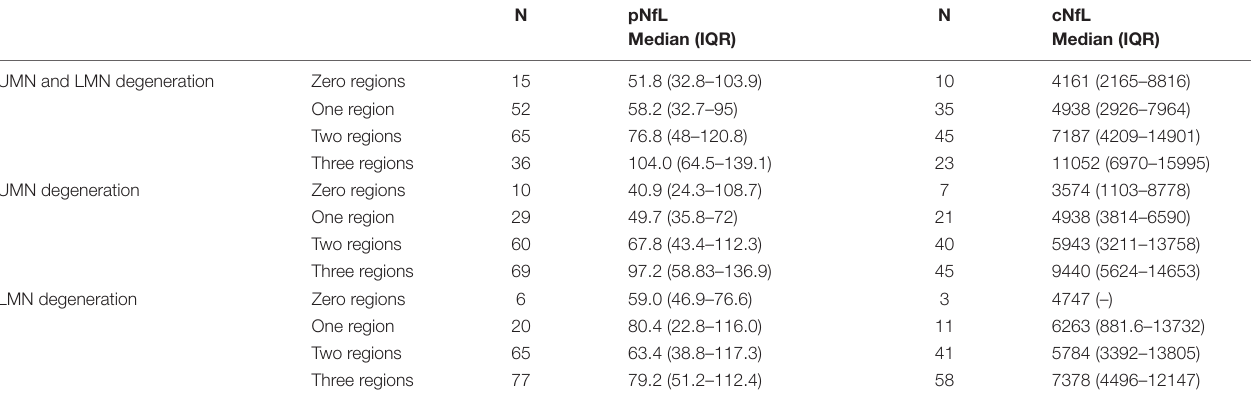
TABLE 4 | pNfL and cNfL levels according to the extent of UMN and/or LMN degeneration.